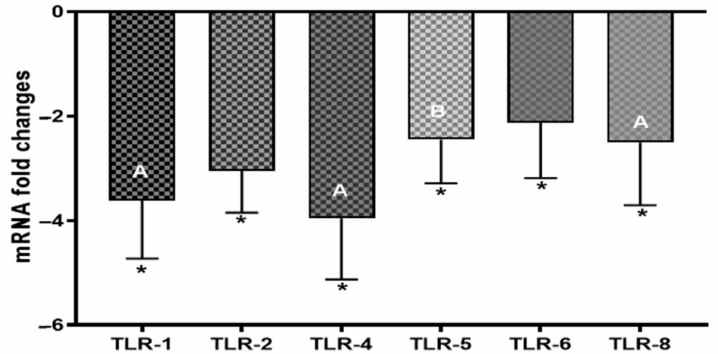
Figure 9. TLR-1, TLR-2, TLR-4, TLR-5, TLR-6, and TLR-8 mRNA fold-change following a 24 h co-culture of ST285 with monocytes ( n = 3), compared to control monocytes. The innate and adaptive RT 2 gene profiler arrays were used to determine changes in gene expression. The symbol represents the p -value for Tukey’s test (one-way ANOVA) where * p <